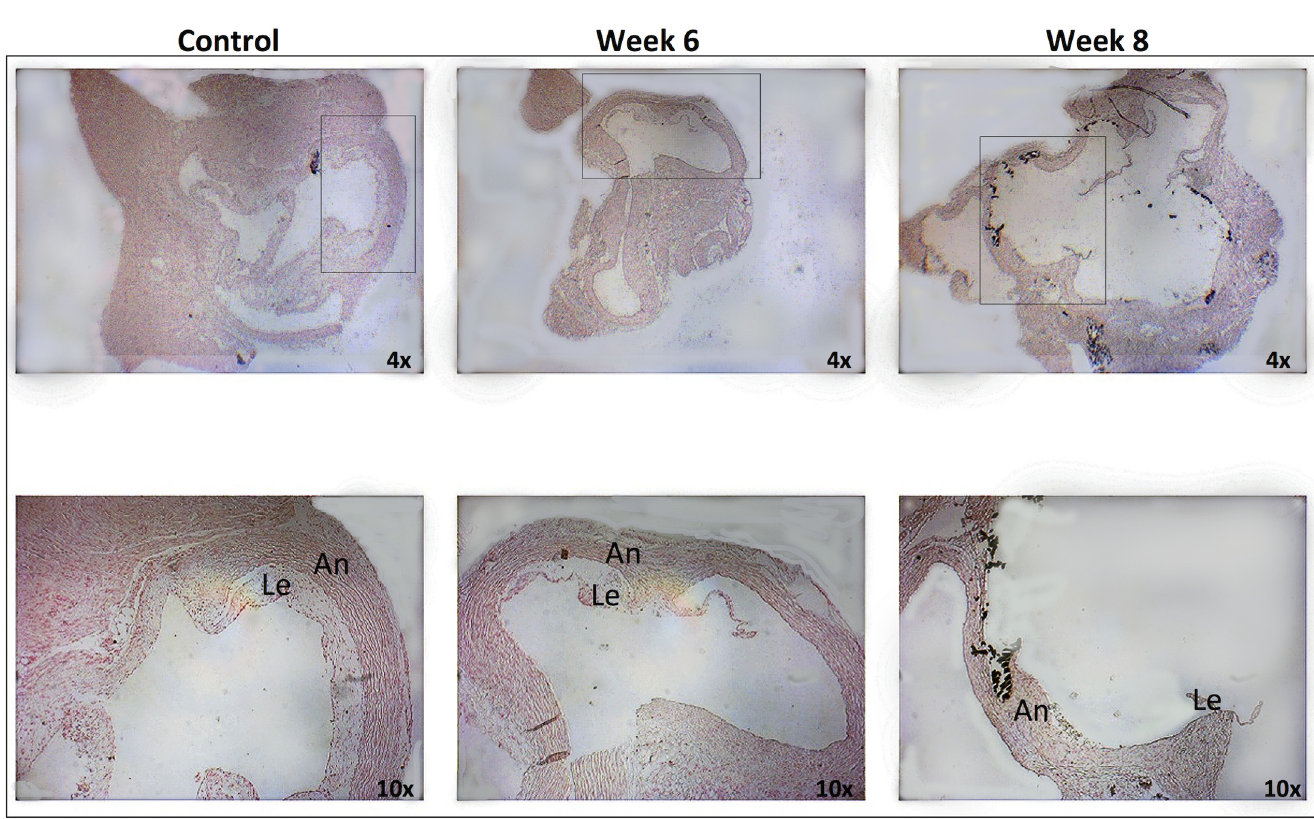
Fig 1. Aortic valve histology. Cross-sections of valves after 6 and 8 weeks on the diet and from controls, showing calcification of the annulus (An) and base of the leaflet (Le) after 8 weeks. No significant calcification was observed in the other groups (von Kossa